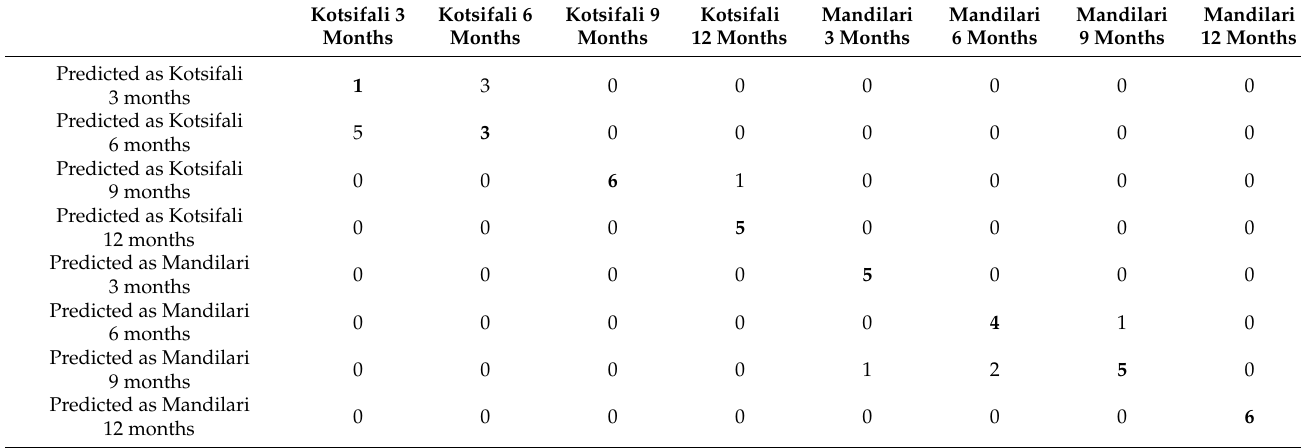
Table 3. Classification of red wines (2013 vintage) as per aging time with